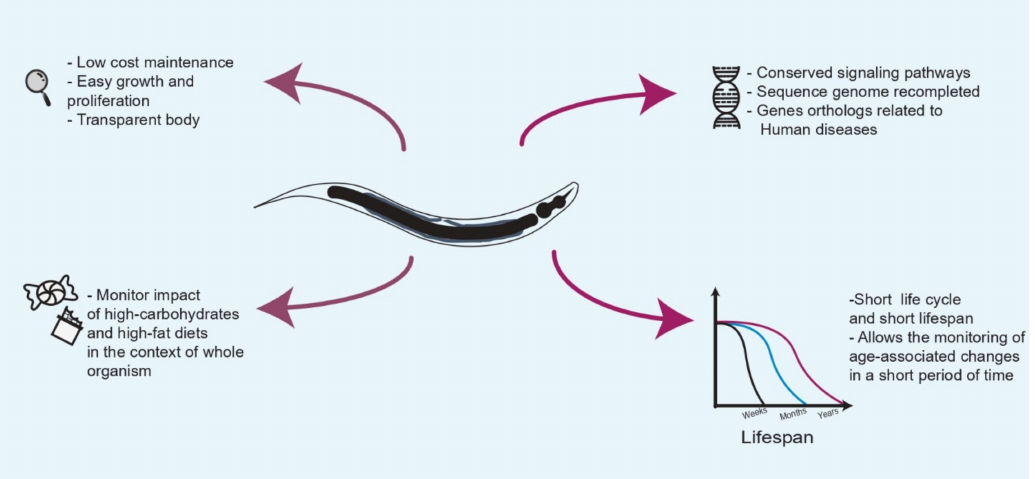
Figure 1. Caenorhabditis elegans as a model organism to study the effects of high-carbohydrate and high-fat diets on the lifespan. C. elegans offers many technical and biological advantages, since it has been shown that develops many of the cellular and molecular alterations reported in humans caused by overconsumption of sugars and